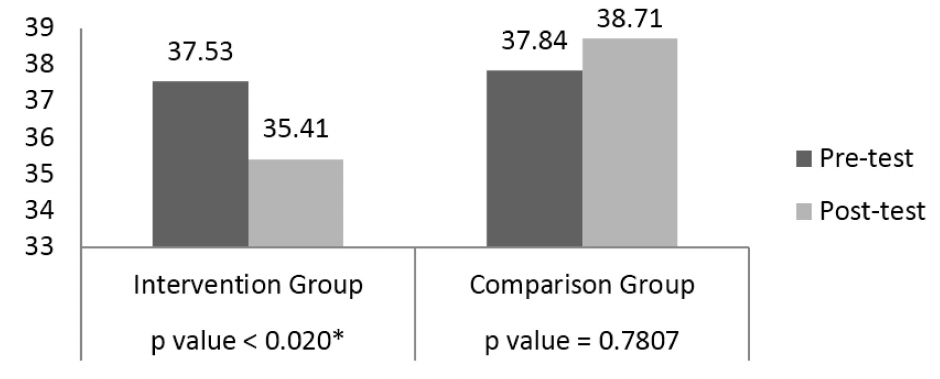
Figure 1. Perceived Stress Scale Composite Score for Intervention and Comparison